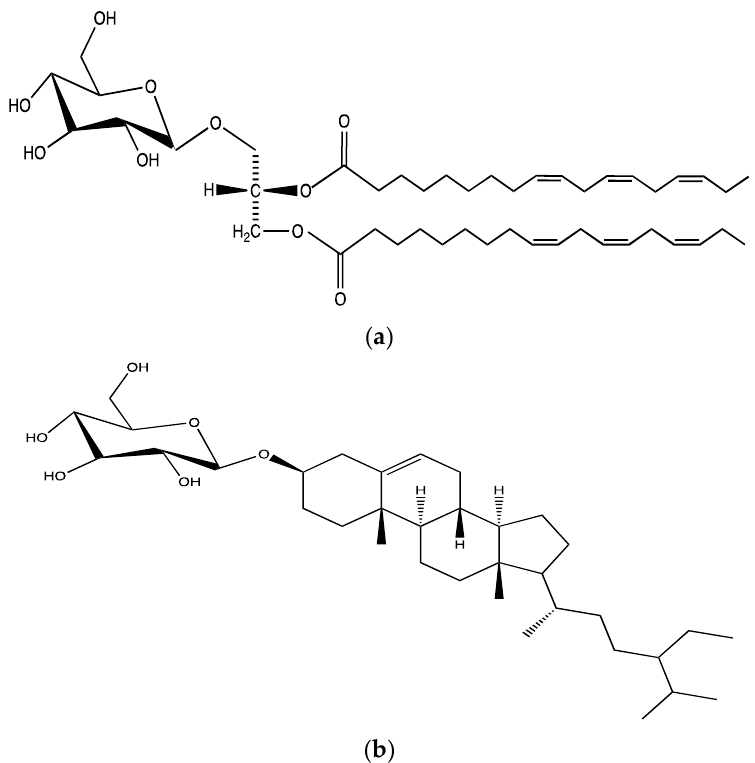
Figure 5. Chemical structures of ( a ) 1,2-di- O -α-linolenoyl-3- O -β- D -galactopyranosyl-sn-glycerol and ( b ) β-sitosterol-3- O -β- D -glucoside isolated from chloroform fractions of methonolic extract of A. ursinum.